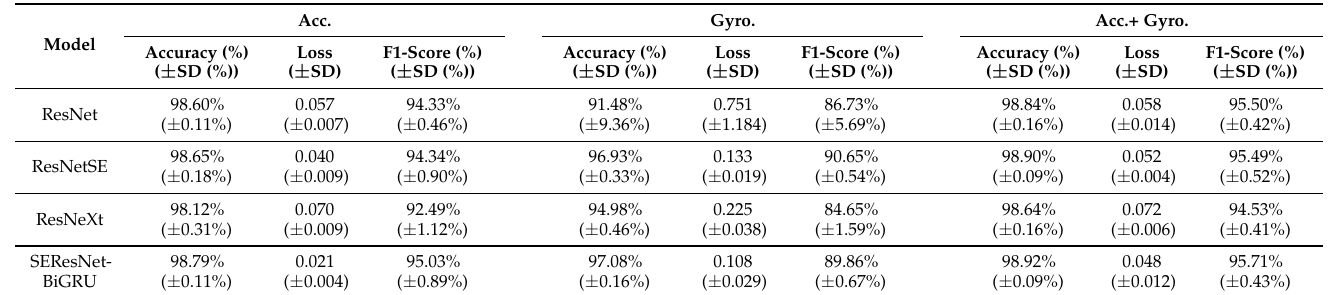
Table 5. Recognition effectiveness of DL models on the MobiAct v2.0 dataset by using different sensor data.